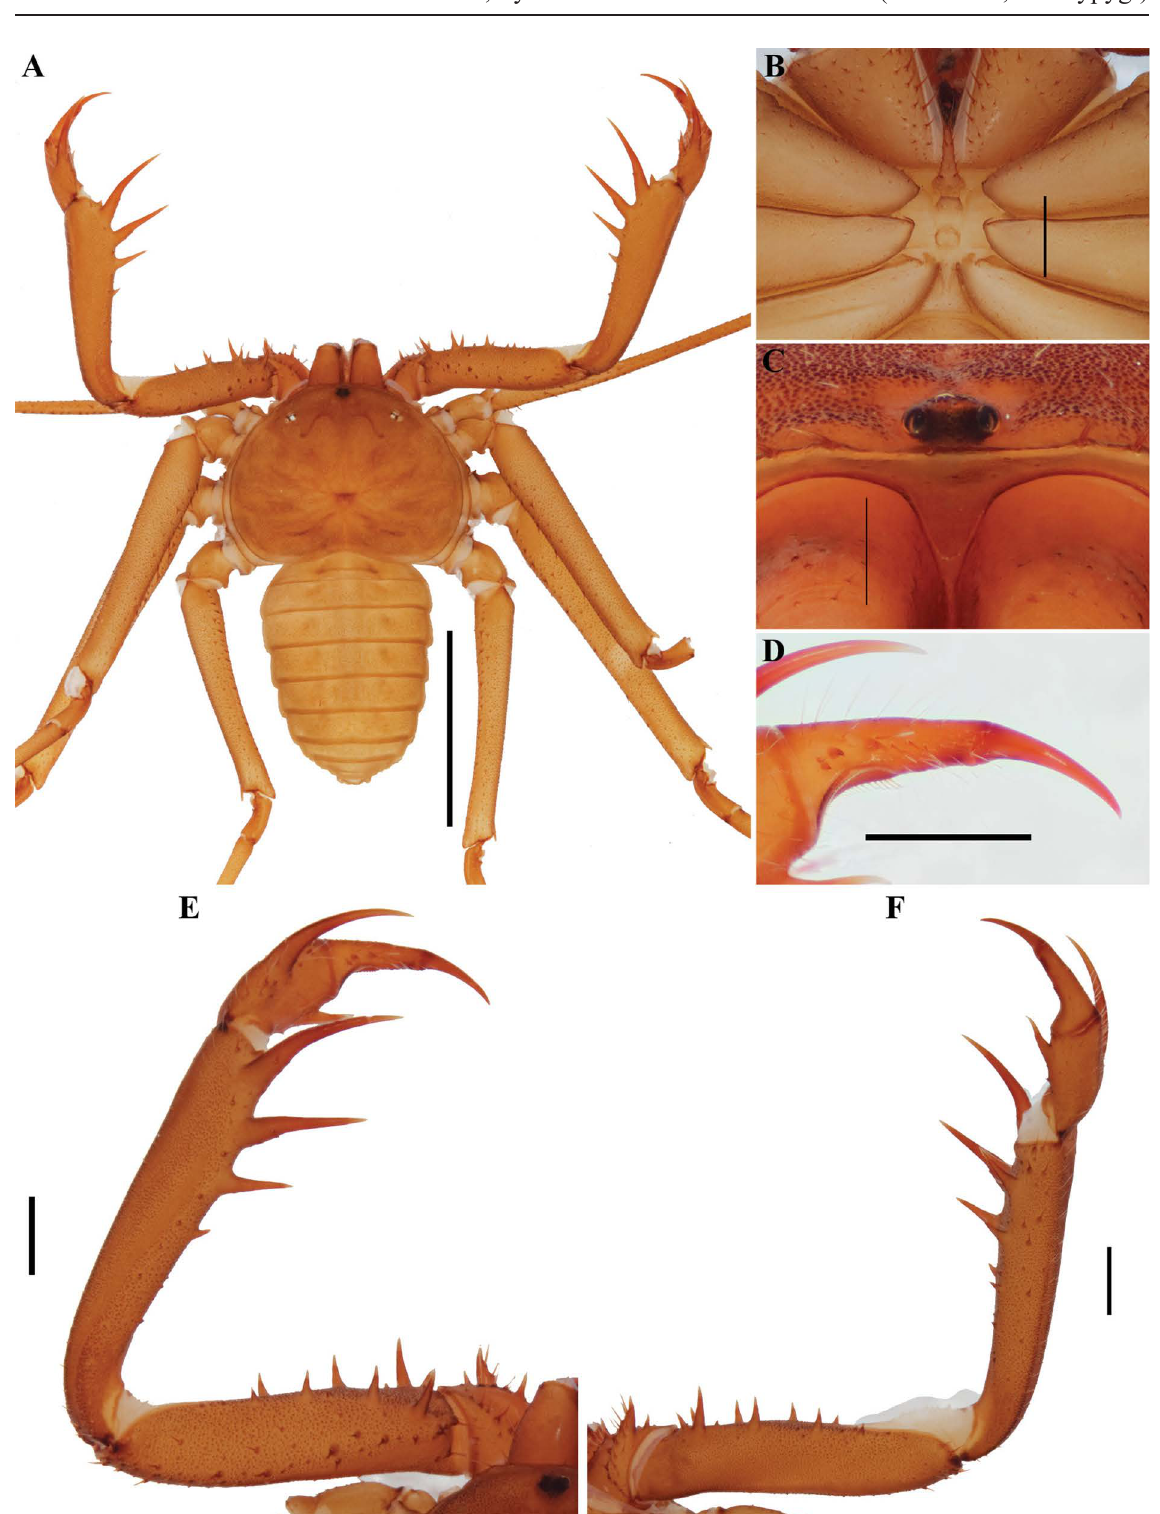
Fig. 49. Charinus carinae sp. nov. (MNRJ 9293), general morphology, ♂. A . Habitus, dorsal view. B . Sternum, ventral view. C . Frontal process. D . Pedipalp tarsus, frontal view. E . Pedipalp, dorsal view. F . Pedipalp, ventral view. Scale bars: A = 5 mm; B, D–F = 1 mm; C =